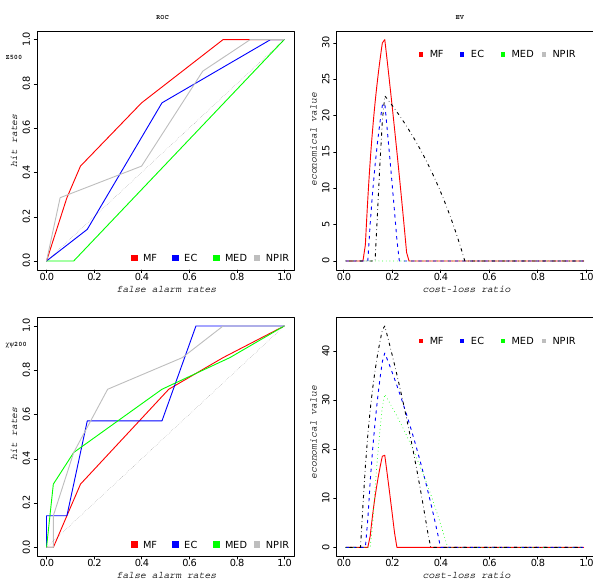
Fig. 9. HPE ROC curves (left; false alarm rates in abscissa, hit rates in ordinate) and EV Economical Value curves (right; cost-loss ra- tio in abscissa, economical values in ordinate) for the MOS LDA methodology; Z500 (top), χψ 200 (bottom), from each forecast set.